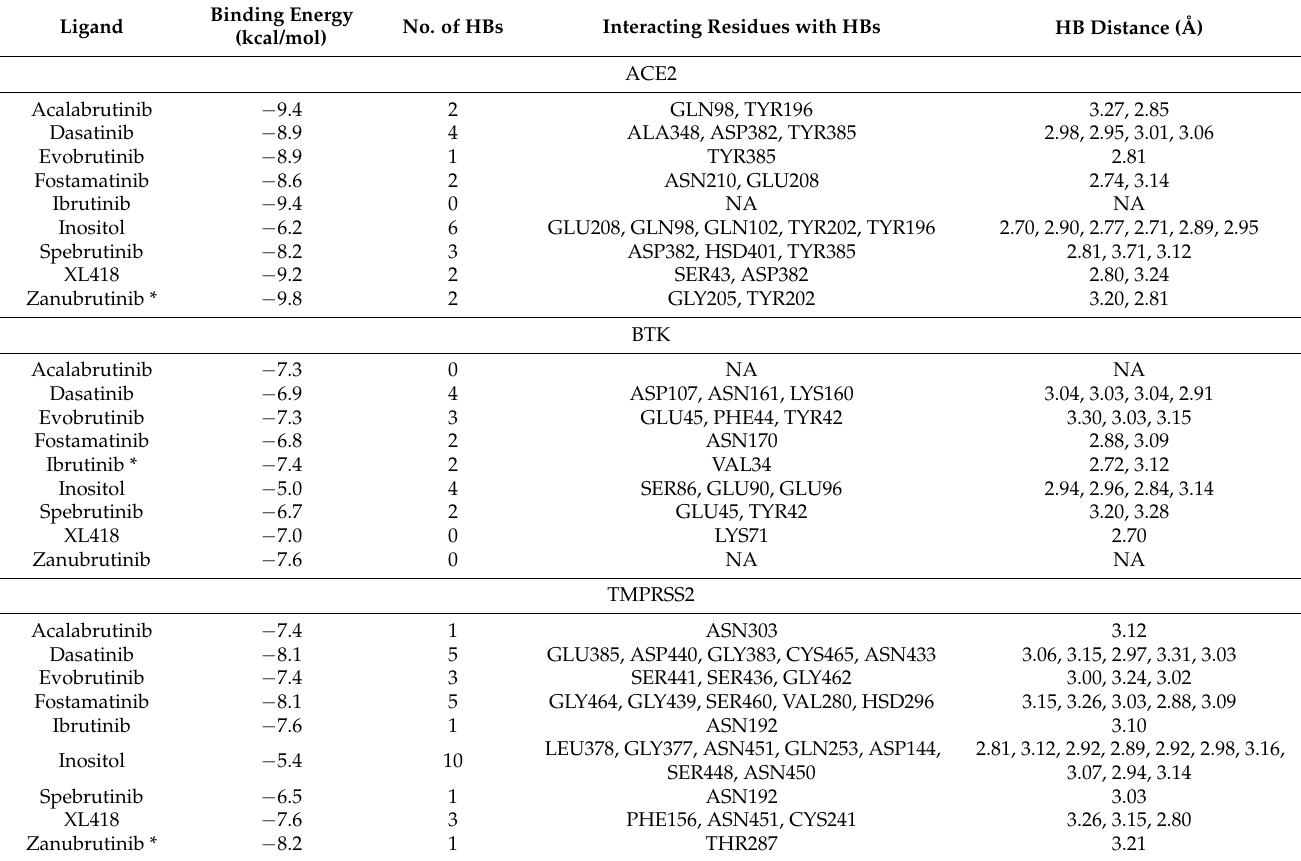
Int. J. Mol. Sci. 2021 , 22 , x FOR PEER REVIEW * indicates the complex selected for further studies; ACE2—angiotensin-converting enzyme 2; BTK—Bruton’s tyrosine kinase; HBs—hydrogen bonds; NA—not available; TMPRSS2—transmembrane serine protease 2.